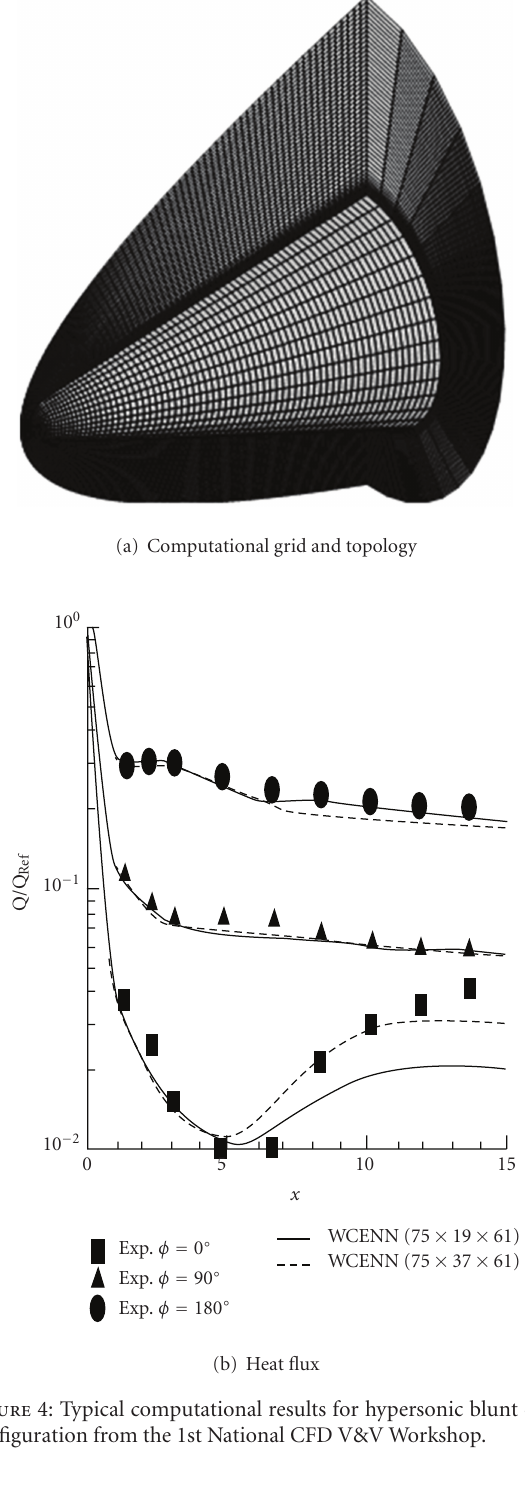
Figure 4: Typical computational results for hypersonic blunt cone configuration from the 1st National CFD V&V